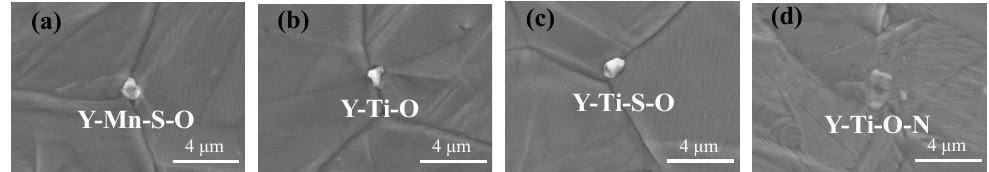
Figure 6. SEM images of the inclusions observed in experiment: ( a ) C1, ( b ) C2, ( c ) C3, and ( d ) C4.